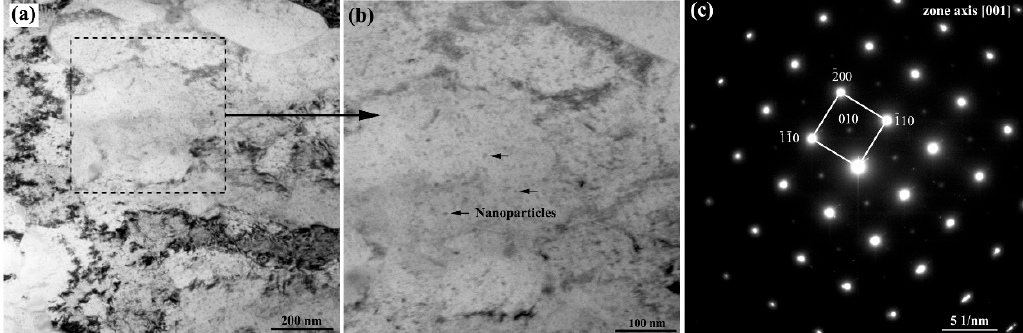
Figure 5. ( a , b ) TEM bright-field micrographs for the AG50h steel and ( c ) the respective [001] zone-axis selected area diffraction patterns for the steel with (010)-type superlattice reflections.